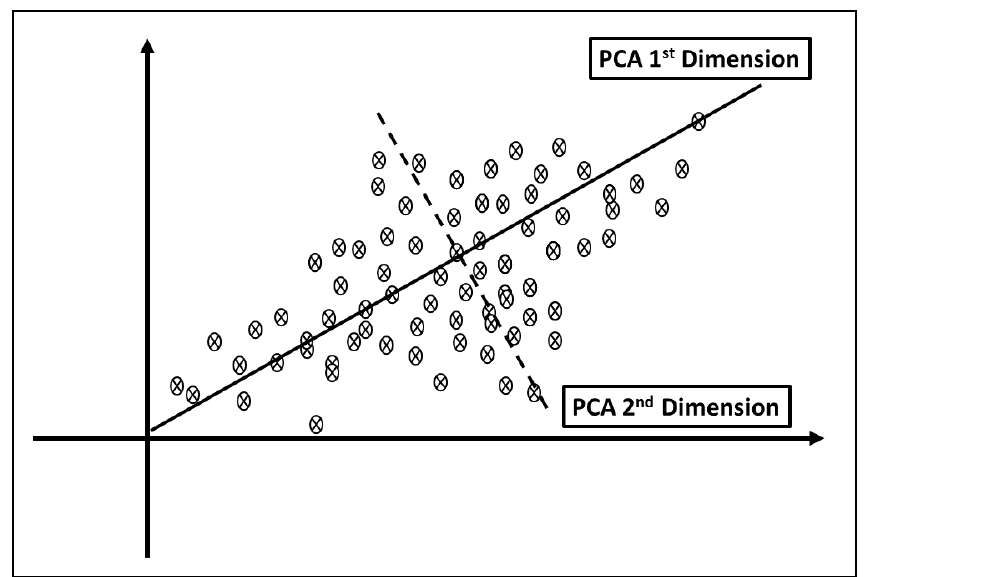
Figure 4. Basic projection of PCs as linear combinations of original